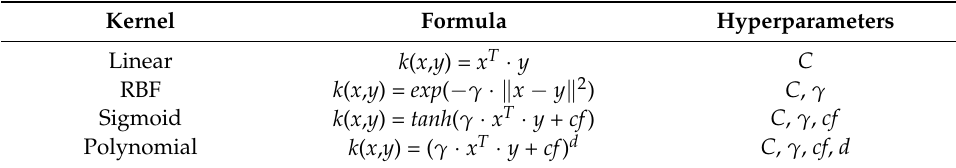
Table 2. Mathematical expressions of the support vector machine (SVM) kernels. RBF: radial basis function.